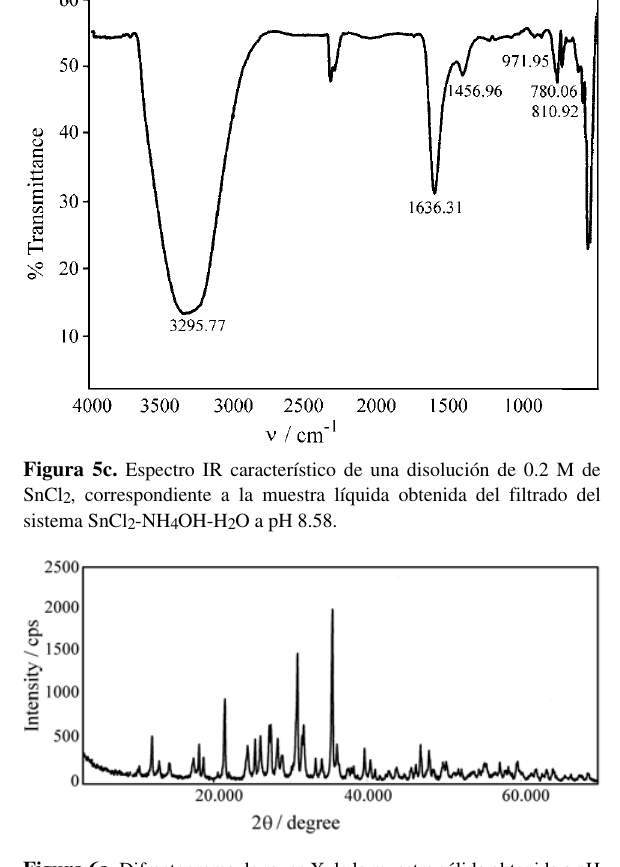
Figura 6a. Difractograma de rayos X de la muestra sólida obtenida a pH 1.86 de la disolución 0.2 M de SnCl 2 .